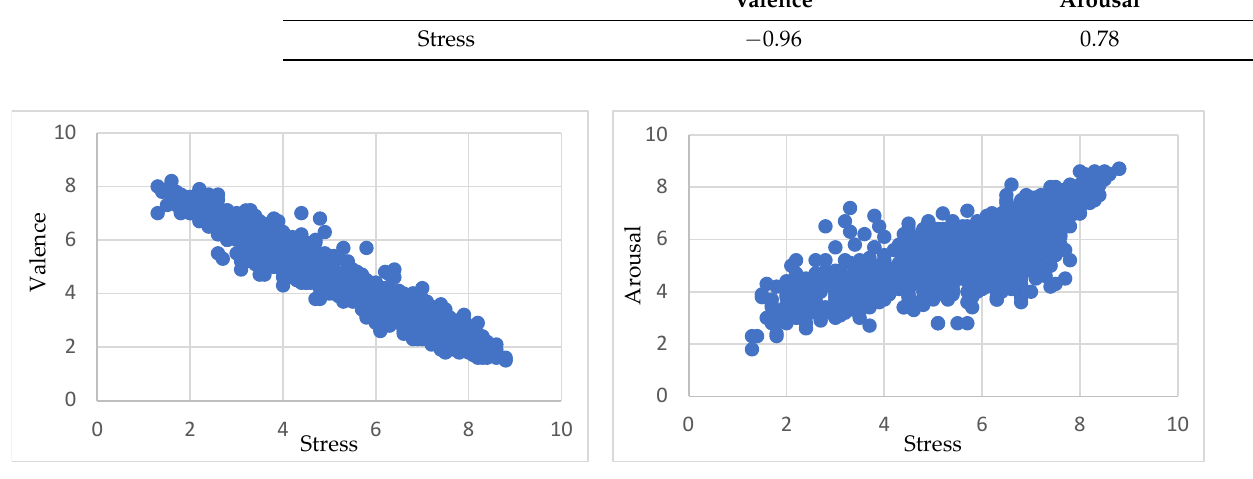
Table 5. The t -test evaluated valence and arousal values in the stress and non-stress groups.